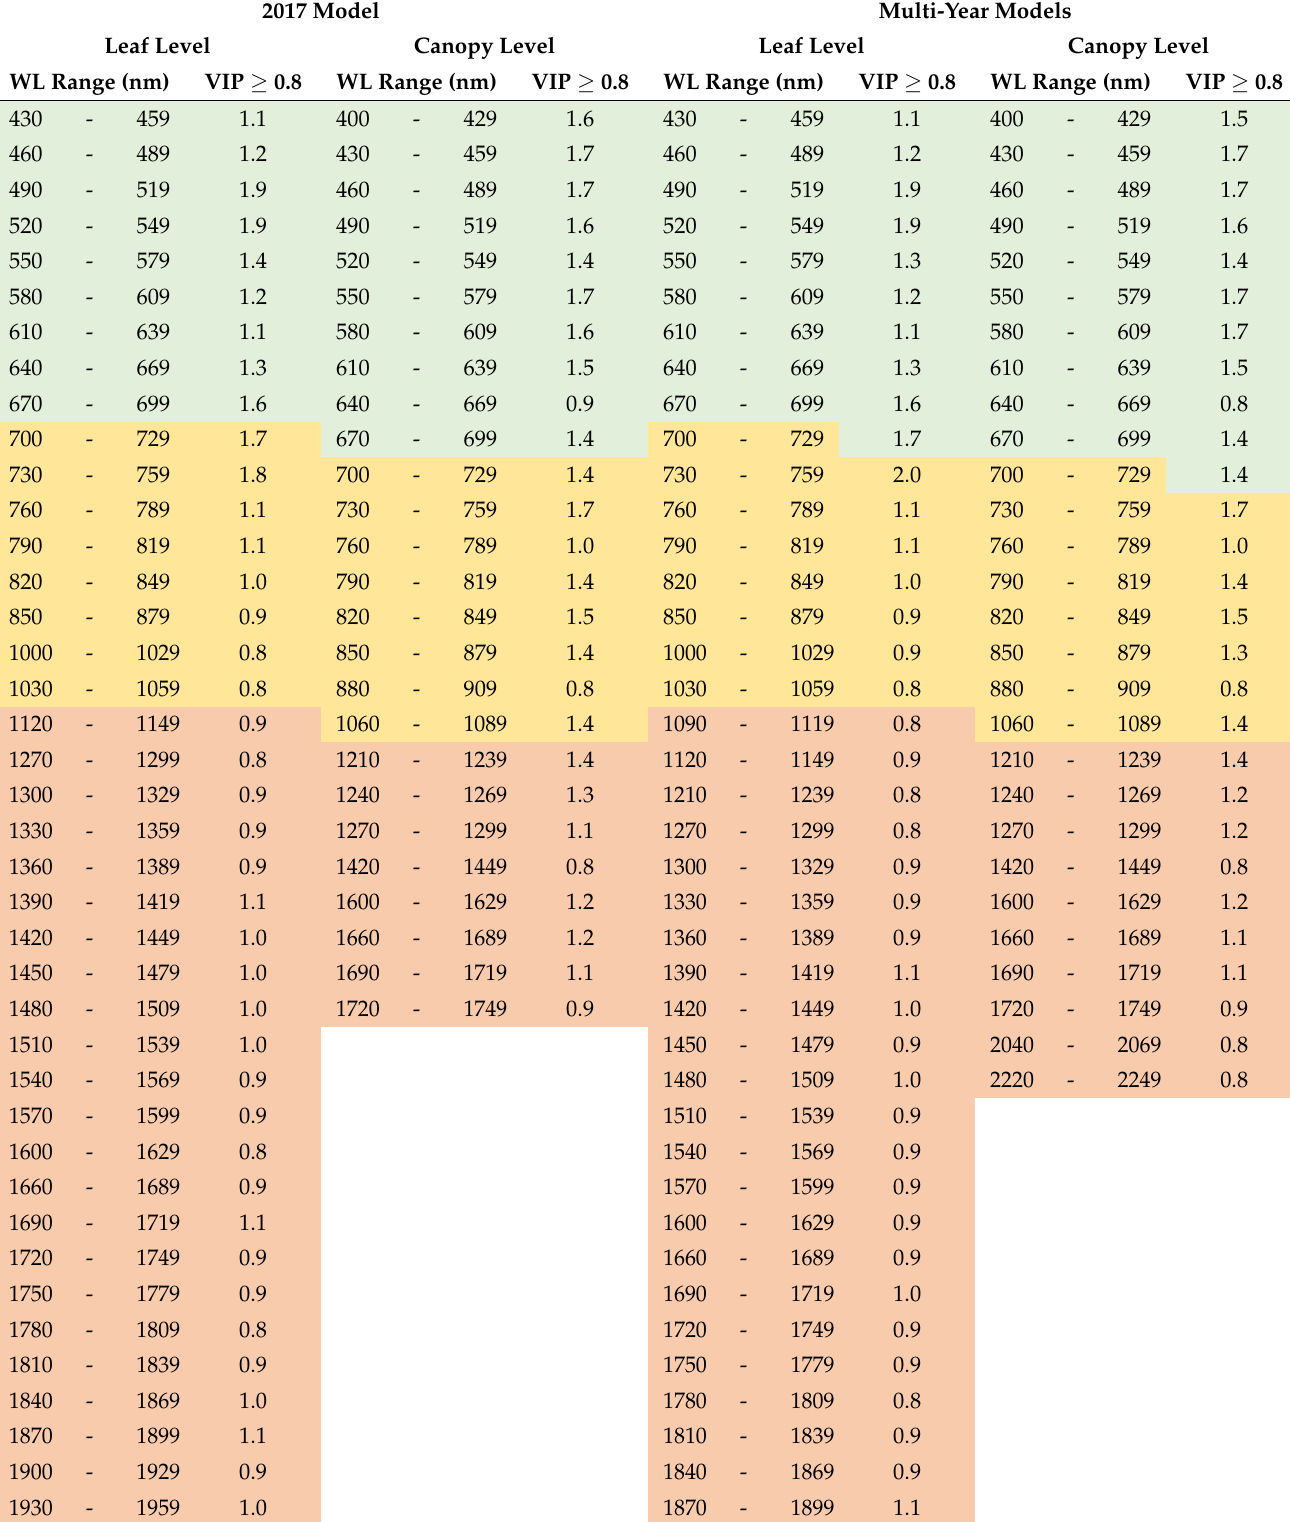
Table A7. Variable importance for the projection (VIP) values ≥ 0.8 2017 and multi-year models at both leaf and canopy levels. The VIP values displayed in this table represent the average VIP value after averaging VIP data every 30nm, as described by the wavelength range (WL Range (nm)). Colors highlighting the three main areas of the full-spectral range: green, visible (VIS); orange, near-infrared (NIR); and red, short-wave infrared